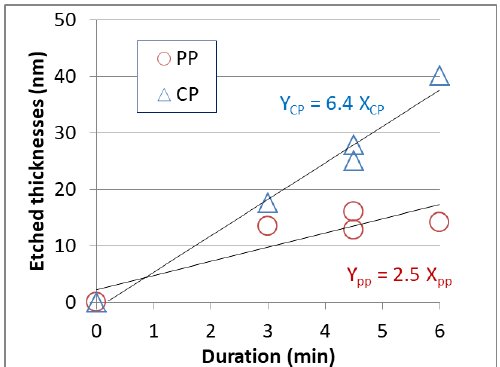
Figure 4. Etched thicknesses of SiN x films deposited by PP and CP PECVD in 3.85 vol % HF solution. The film thicknesses were measured by ellipsometer. Each specimen was recorded at five locations and the variations may come from the non-uniform etching rate in whole wafers and from the measuring uncertainties.